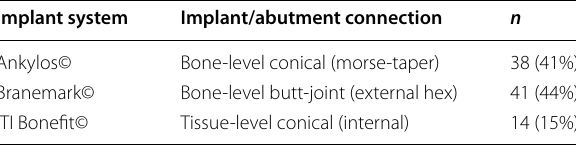
Table 2 Distribution of the implant systems used Implant system